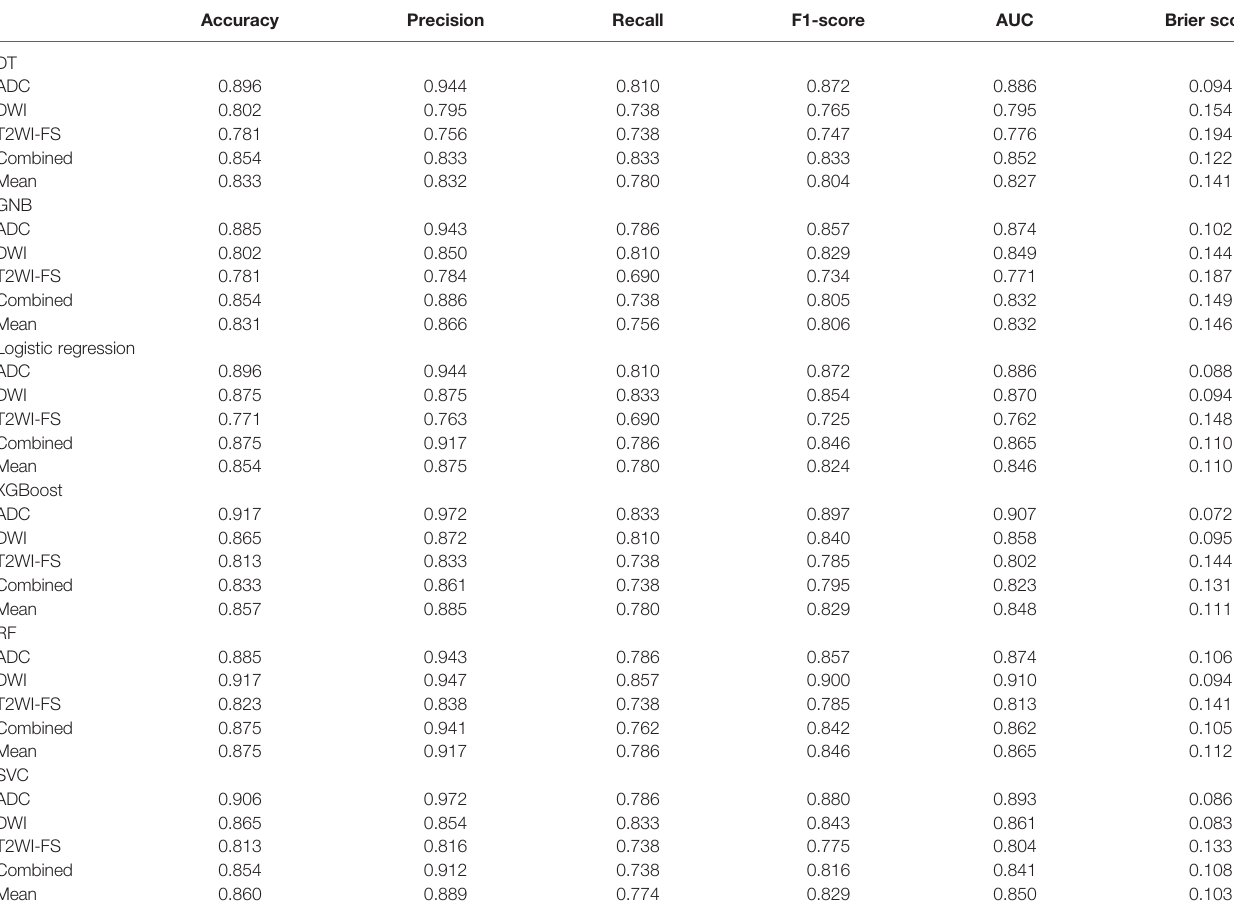
TABLE 3 | Accuracy, precision, recall, F1-score, AUC, and Brier score results of mpMRI and combined models based on patients for predicting PCa. Accuracy Precision Recall